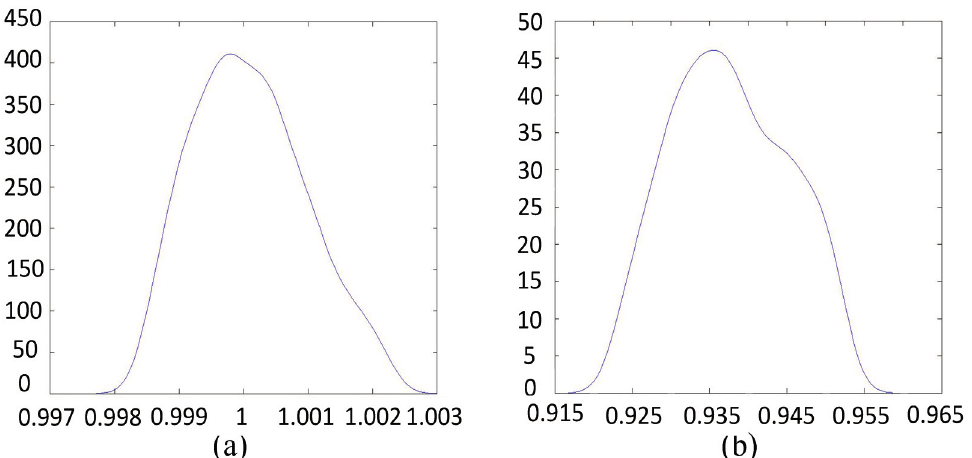
Figure 3. Distributions for features 1 ( a ) and 3 ( b ) of points projected onto the road